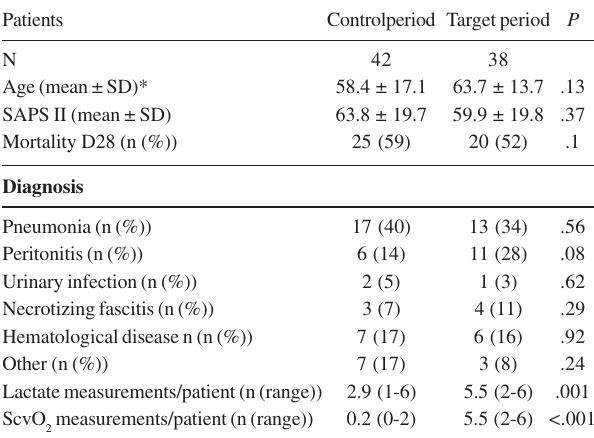
Table 1 - Characteristics of septic shock patients during the 2 periods. Demographic data, diagnosis, and number of blood lactate and ScvO 2